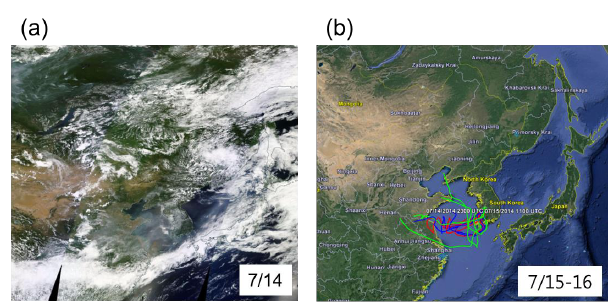
Figure 7. (a) MODIS RGB image on 14 July 2014 and (b) air mass backward trajectories between 15 and 16 July 2014 when haze plumes originating from East China had an impact on the Korean